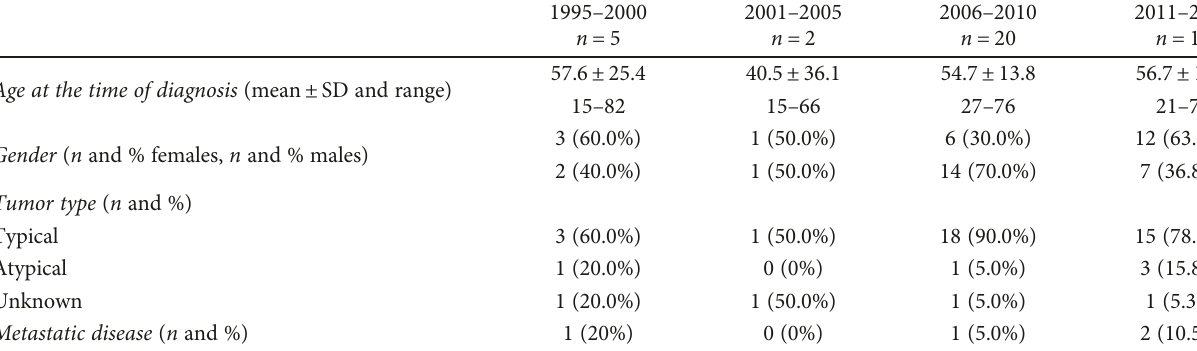
Table 4: Characteristics of bronchial NET patients managed at our institution divided in chronological time frames.